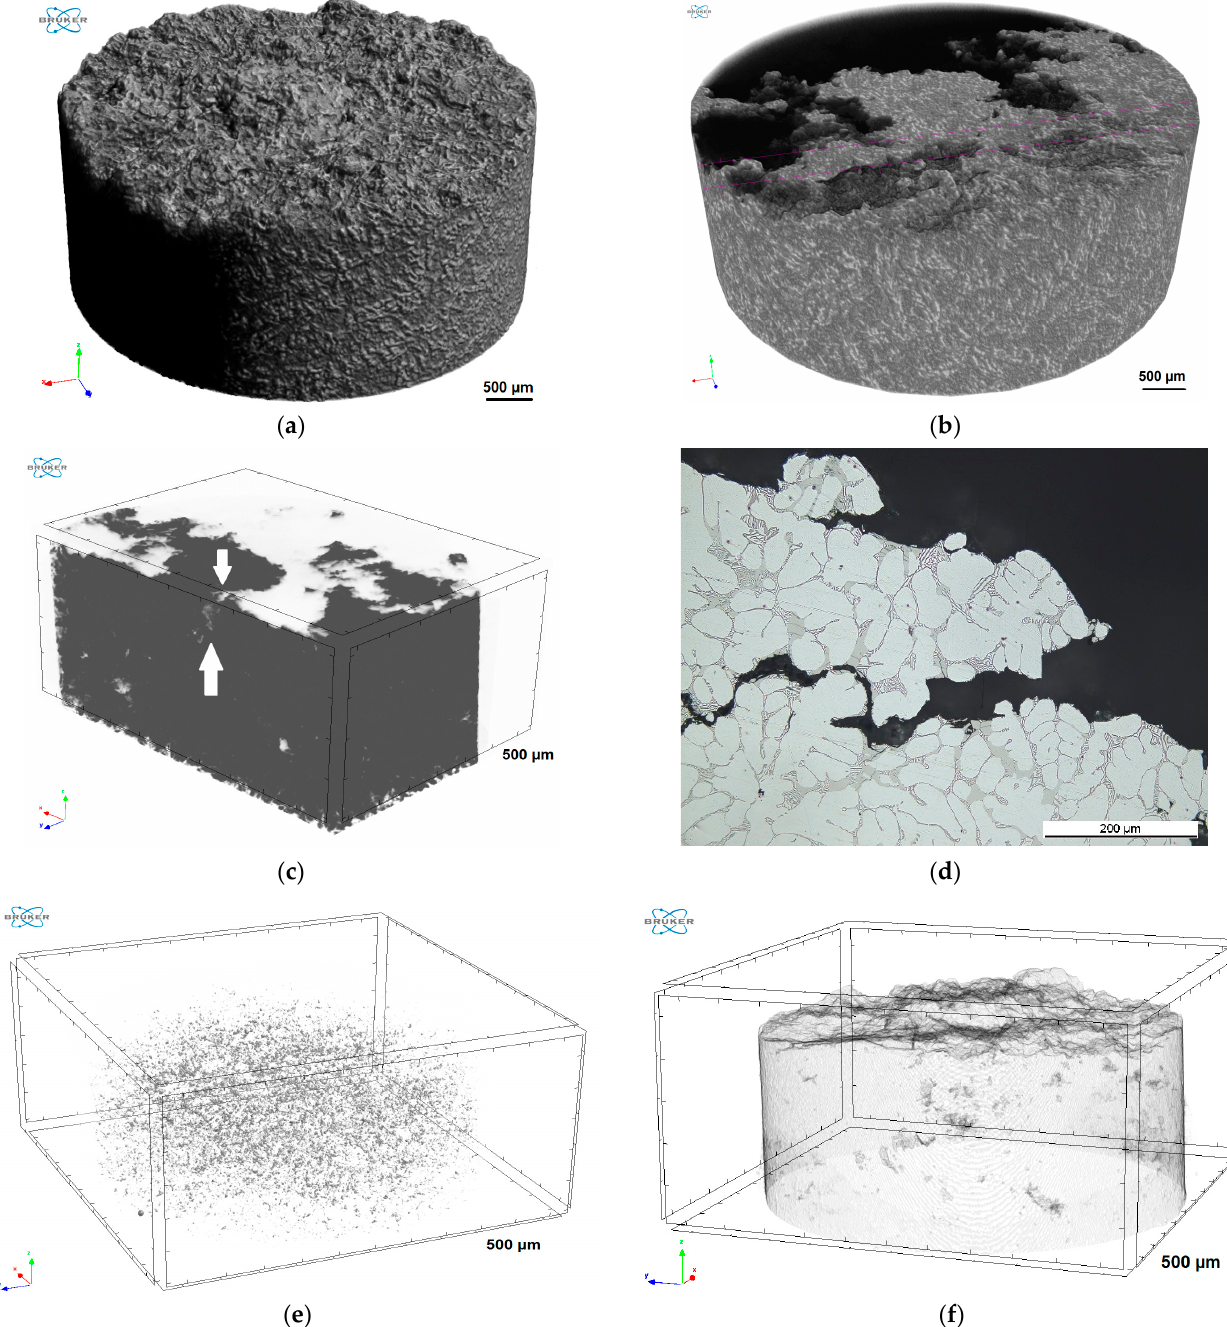
Figure 7. µ-CT analysis of a fracture surface after fatigue loading (R = 0, 43,300 cycles): top view in direction of crack propagation ( a ), cut to size fracture surface to present sub-cracks ( b ), cut to cross-section of fracture surface to present the depth of the sub-cracks and the connection to the shrinkage cavities ( c ), cross-sectional micrograph to present the depth of the sub-cracks—connected to some cavities ( d ), network of second phases ( e ) and pores and shrinkage cavities ( f ). Figure 8a–e show cross-sectional micrographs of the fracture surface after fully re- versed fatigue loading (R = − 1); the sample reached 12,000 cycles to fracture. The